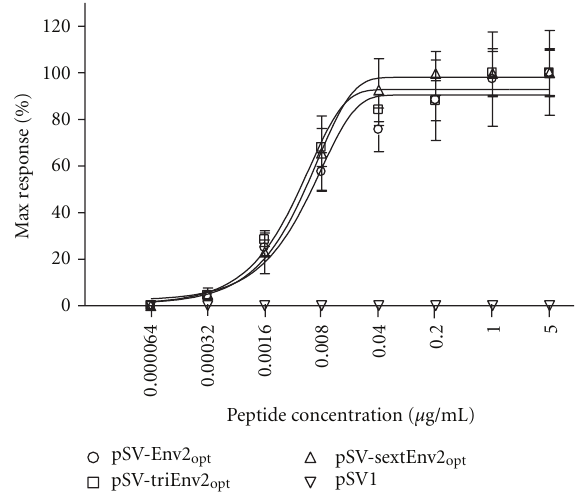
Figure 4: Functional TCR avidity of epitope-specific T cells was similar among all groups. Env2-specific T cell avidity was detected by using an IFN- γ ELISPOT. The dose-e ff ect curve showed no significant di ff erence among groups vaccinated with pSV-Env2 opt , pSV-triEnv2 opt , and pSV-sextEnv2 opt